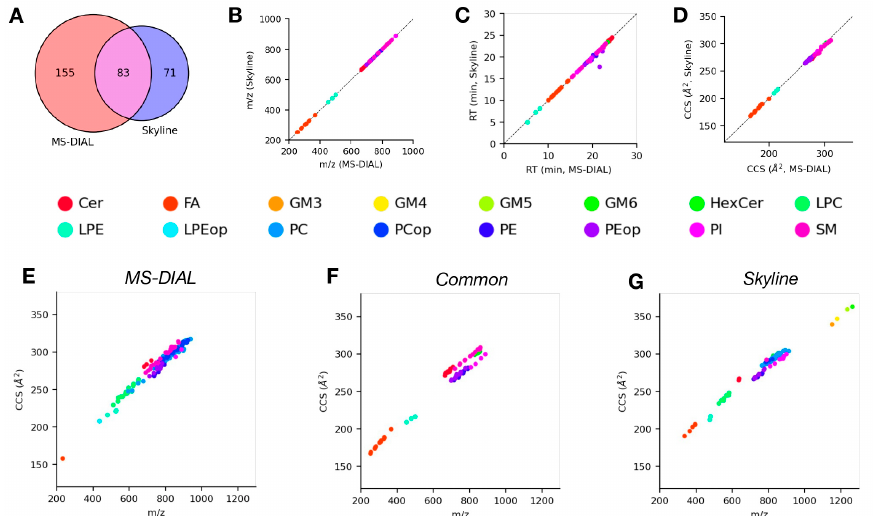
Figure 5. Comparison of lipid identifications from analysis of negative mode LC-TIMS-MS/MS lipidomics data using Skyline and MS-DIAL. ( A ) Venn diagram of lipids identified using either software. ( B – D ) Comparisons of m / z ( B ), retention time ( C ), and CCS ( D ) values from MS-DIAL vs. Skyline for common lipid identifications from both tools, points colored according to lipid class. ( E , F ) CCS trend lines or IMS-MS conformational space of lipids identified by MS-DIAL ( E ), Skyline ( G ), or both tools ( F ), points colored according to lipid